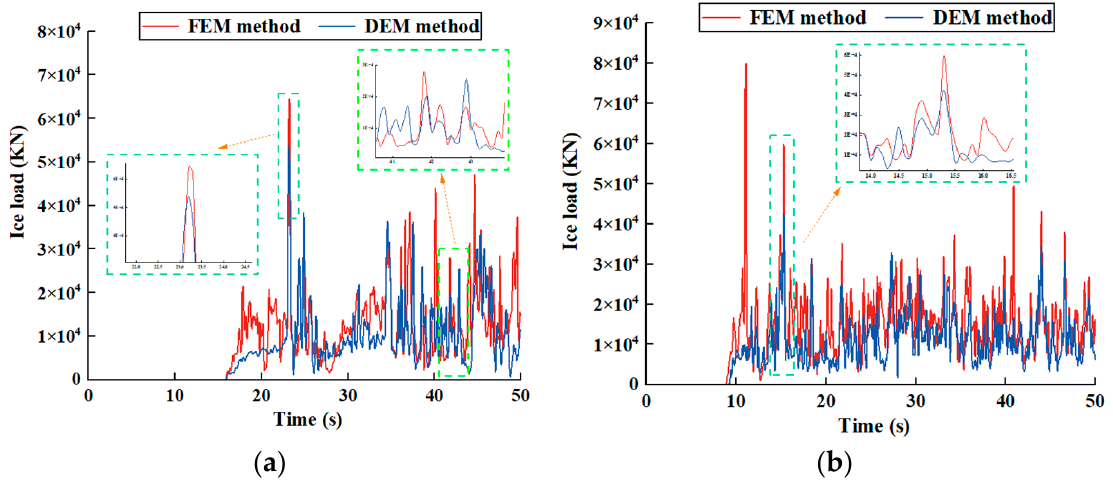
Figure 7. Comparison of different ice load calculation methods. ( a ) 0.6 m/s ice speed; ( b ) 1.2 m/s ice speed.